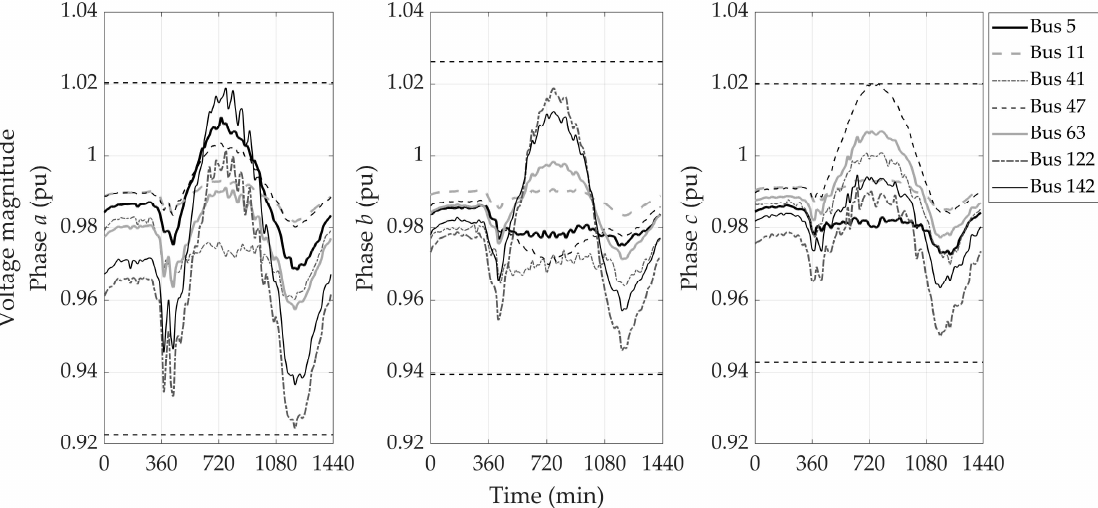
Figure 4. True values of the voltages of the analyzed nodes. The maximum and minimum values within the network are also illustrated. Table 1. Measurement standard deviations.